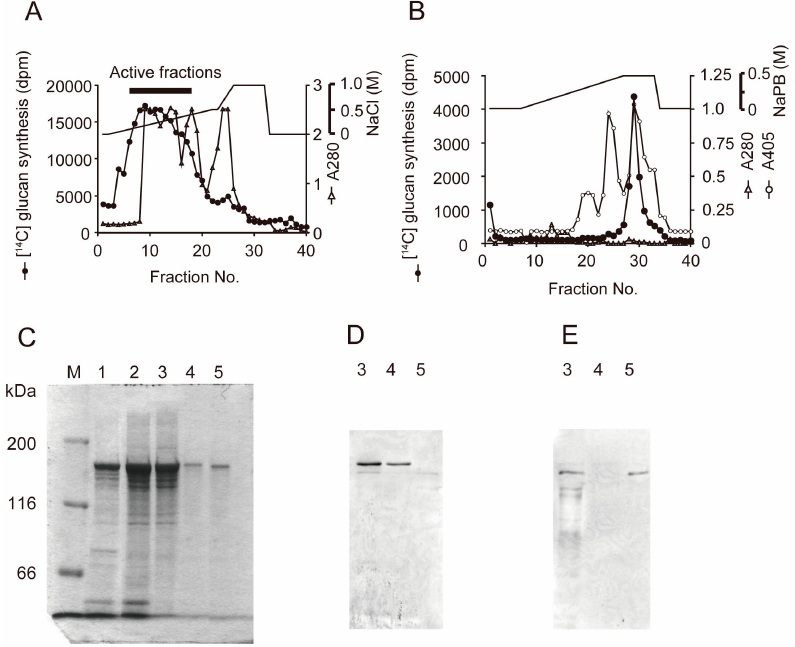
Figure 7. Purification of GTFB and GTFC from S. mutans MT8148, by sequential chromatography on. DEAE Sepharose FF column (collecting No. 6 to No. 17 fractions) ( A ) and Bio-Scale CHT10-I column (collecting No.29 and No.24 fraction as purified GTFB and GTFC, respectively) ( B ). The sample in each purification step was separated by SDS-PAGE ( C ) and assessed with Western blot analyses using anti-GTF-I ( D ), anti-GTF-SI ( E ) antiserum. Lane M, molecular weight marker; 1, 8 M-urea extraction; 2, precipitant of 1 by ammonium sulfate; 3, GTF-active fraction eluted with DEAE Sepharose column; 4, No. 29 fraction eluted with CHT10-I column; No. 24 fraction eluted with CHT10-I column. Cited from Reference [49] with permission.